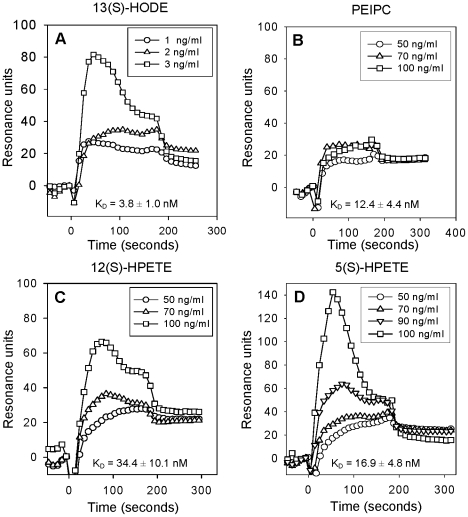
Binding of oxidized lipids to OxP-11D.Abbreviations: 13(S)-HODE: 13(S)-hydroxyoctadecadienoic acid, PEIPC: 1-palmitoyl-2-(5,6-deoxyisoprostane E2)-sn-glycero-3-phosphorylcholine, 12(S)-HPETE: 12(S)-hydroperoxyeicosatetraenoic acid, 5(S)-HPETE: 5(S)-hydroperoxyeicosatetraenoic acid. The biosensor presented 4686 RU of OxP-11D.